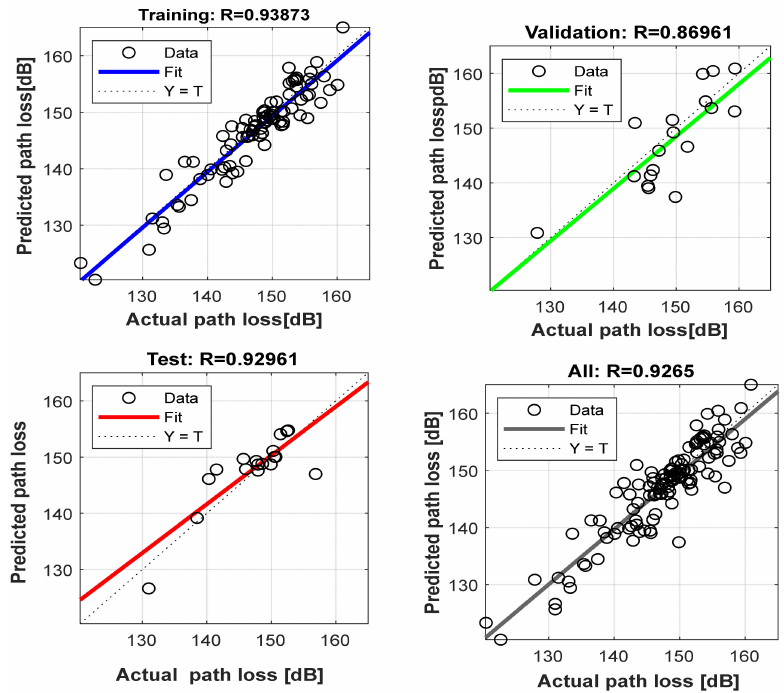
Figure 13. Prediction performance with correlation coefficient in site 2.